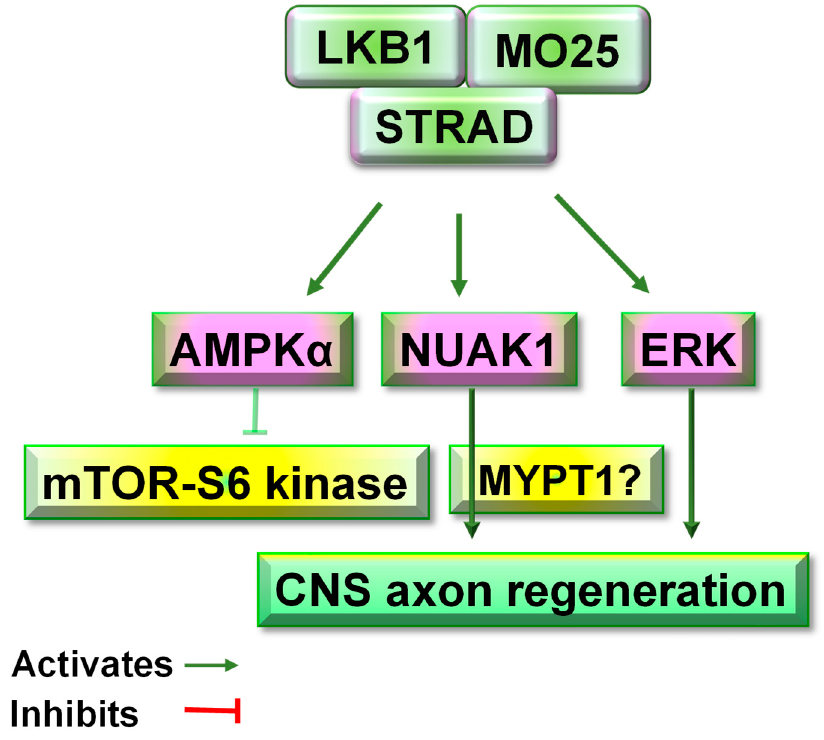
Figure 5. Schematic of the LKB1 signaling pathways in adult mammalian neurons. LKB1 upregulation in the cortical neurons of adult mice by AAV transduction increased the expression of NUAK1 and activated AMPK α and ERK signals. In contrast, LKB1 overexpression reduced the levels of SAD-A, SDA-B, and phosphorylated S6 kinase, and did not alter the levels of phosphorylated Akt and 4E-BP1 [5]. Thus, LKB1 probably regulates the function of mature neurons primarily by activating AMPK α , NUAK1, and ERK signals. It would be interesting to further dissect the comprehensive signaling of LKB1 in adult CNS, such as the possible role of MYPT1 (a myosin phosphatase) in regulating cytoskeletal dynamics downstream of